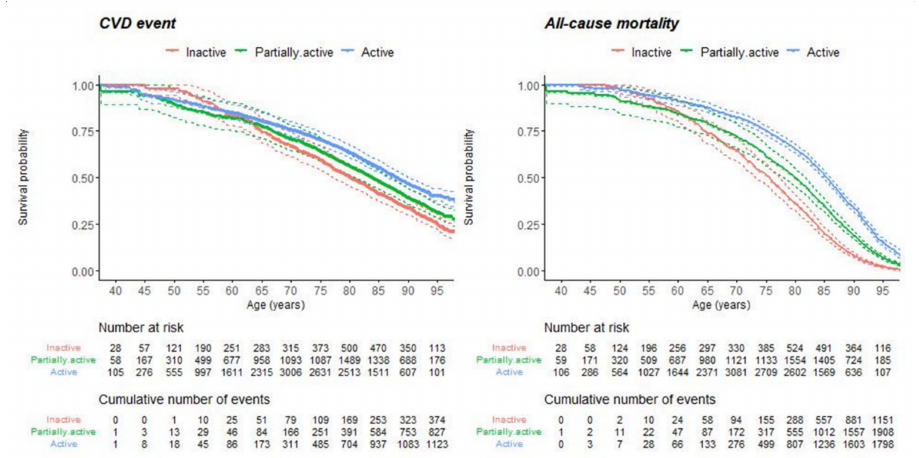
Figure 1. Kaplan–Meier curves by Physical Activity groups.